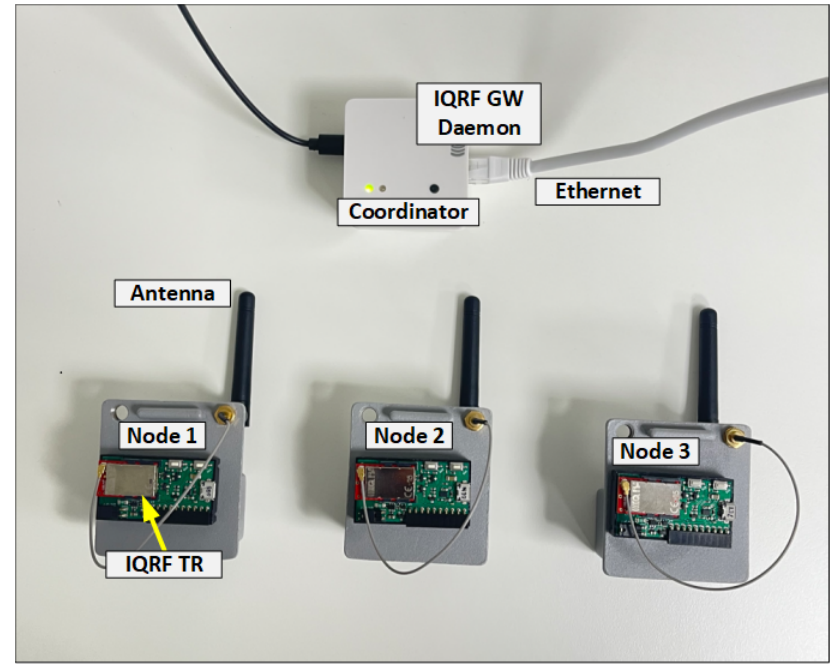
Figure 3. The experiment setup. Three IQRF nodes, one coordinator node, and one